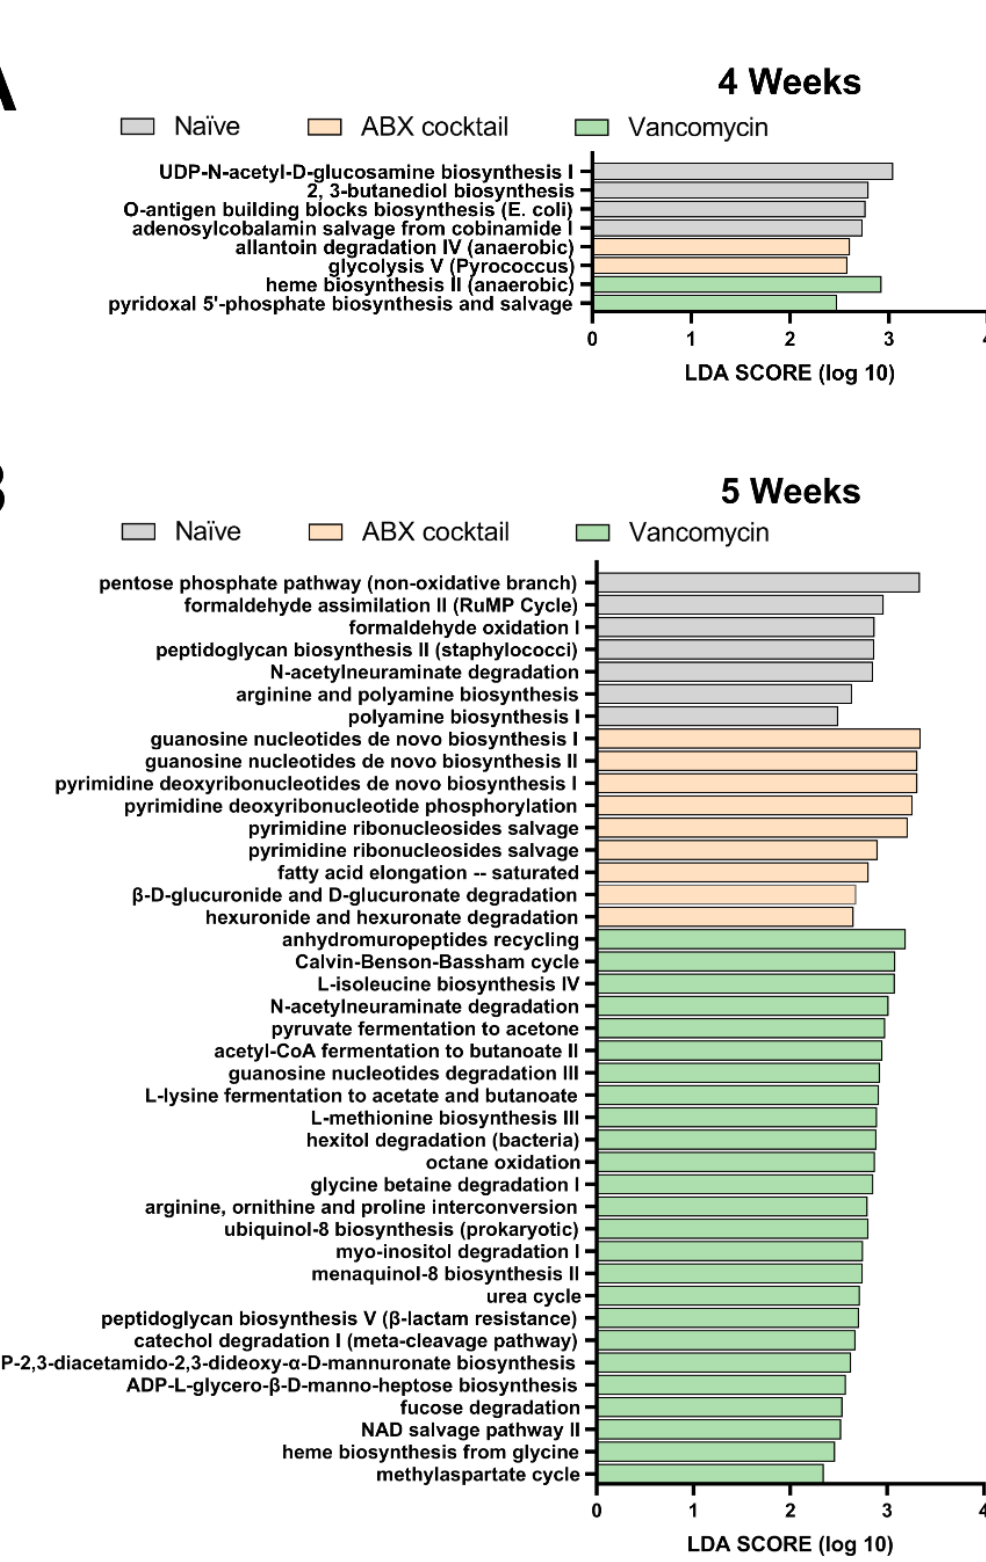
Figure 4. PICRUSt predictions of metabolic pathways. Functional summary for MetaCyc pathways, Linear discriminant analysis (LDA) effect size (LEfSe) analysis revealed significant bacterial differ- ences in gut microbiota between the antibiotic-treated groups and naïve group. from ( A ) 4 weeks and ( B ) 5 weeks. LDA scores (log10) > 2 and p < 0.05 are shown. Naïve = light grey, ABX cocktail = light brown, Vancomycin = light green, with n = 12 per group.